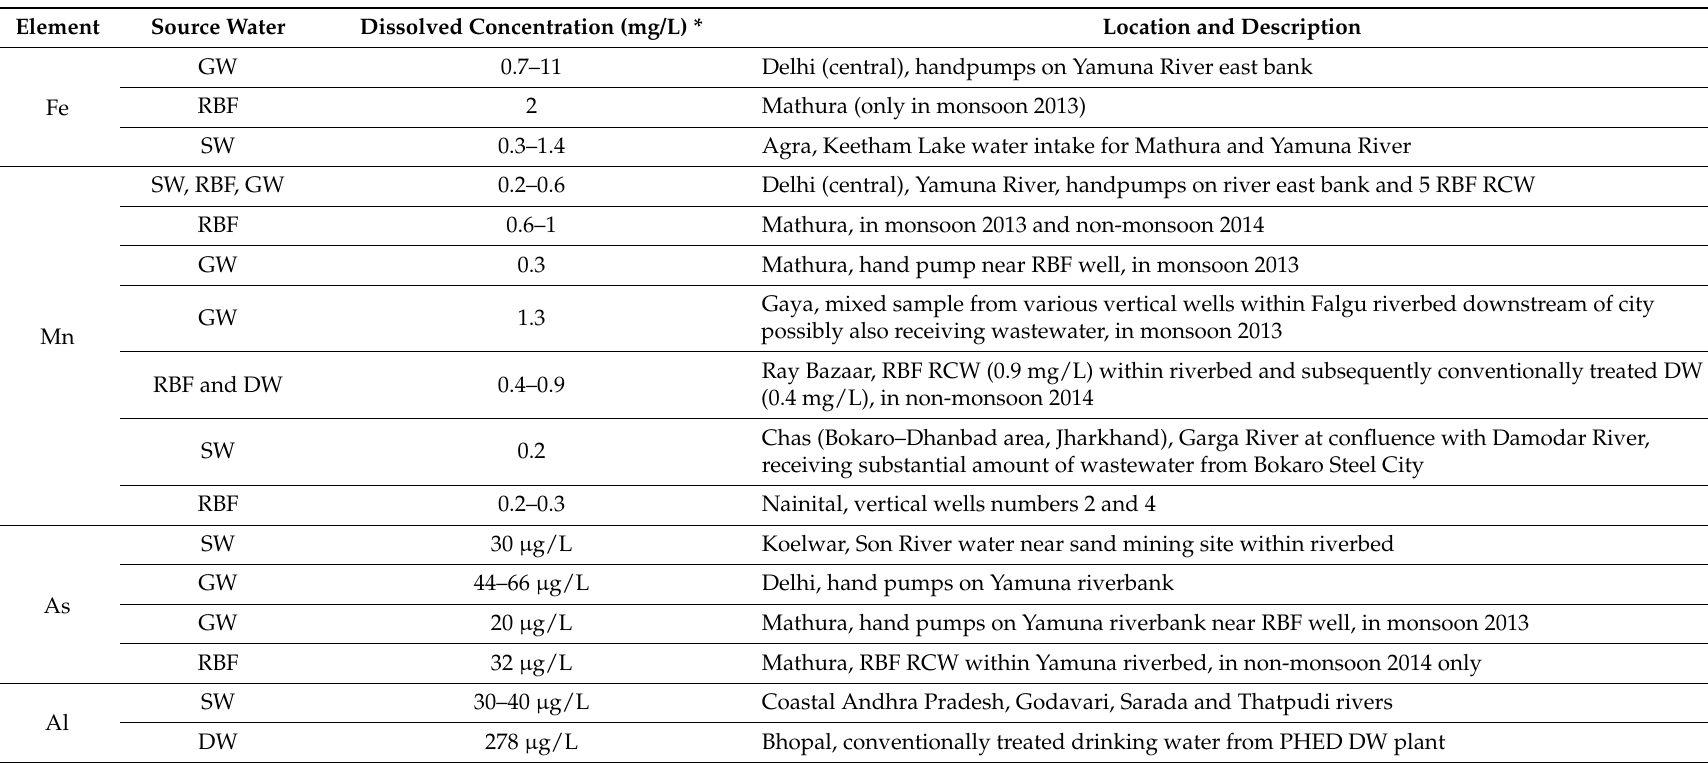
Table 2. Summary of inorganic parameters exceeding acceptable limits [17] determined in 2013 and